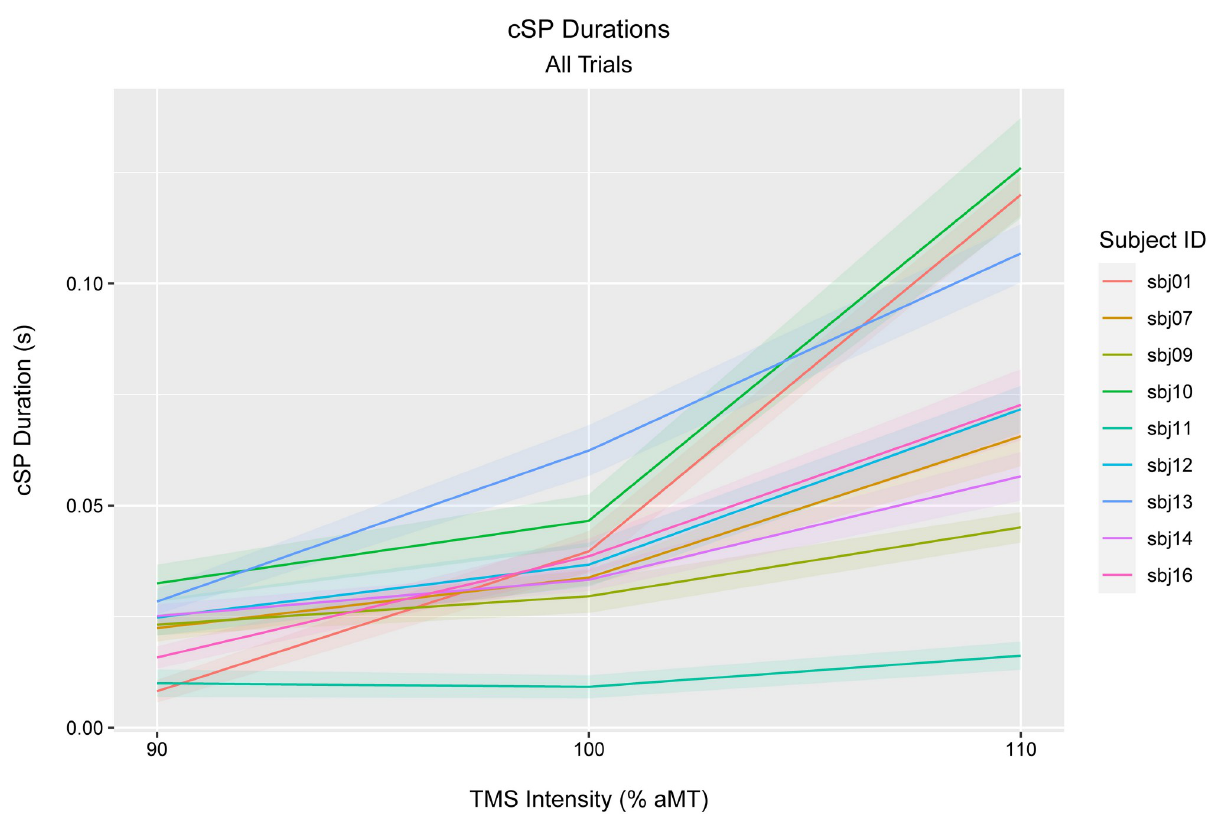
Fig 4. cSP length for each TMS intensity, per subject. Line: median. Ribbon: standard error of the mean. One subject (sbj08) with whom resting motor threshold was used is not shown here (see S8 Fig).